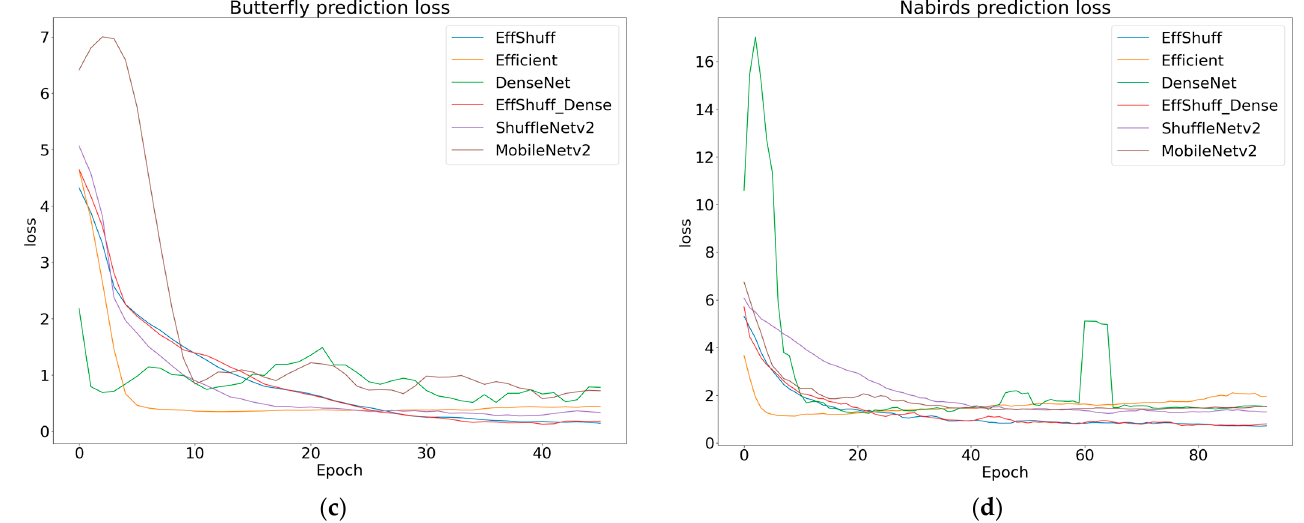
Figure 9. Loss comparison of EffShuffNet, EffShuffDenseNet and other models in validation scheme. ( a ) The Audience dataset: age prediction; ( b ) the Audience dataset: gender prediction; ( c ) the Butterfly & Moths dataset: class prediction; ( d ) the NA Birds dataset: class prediction.